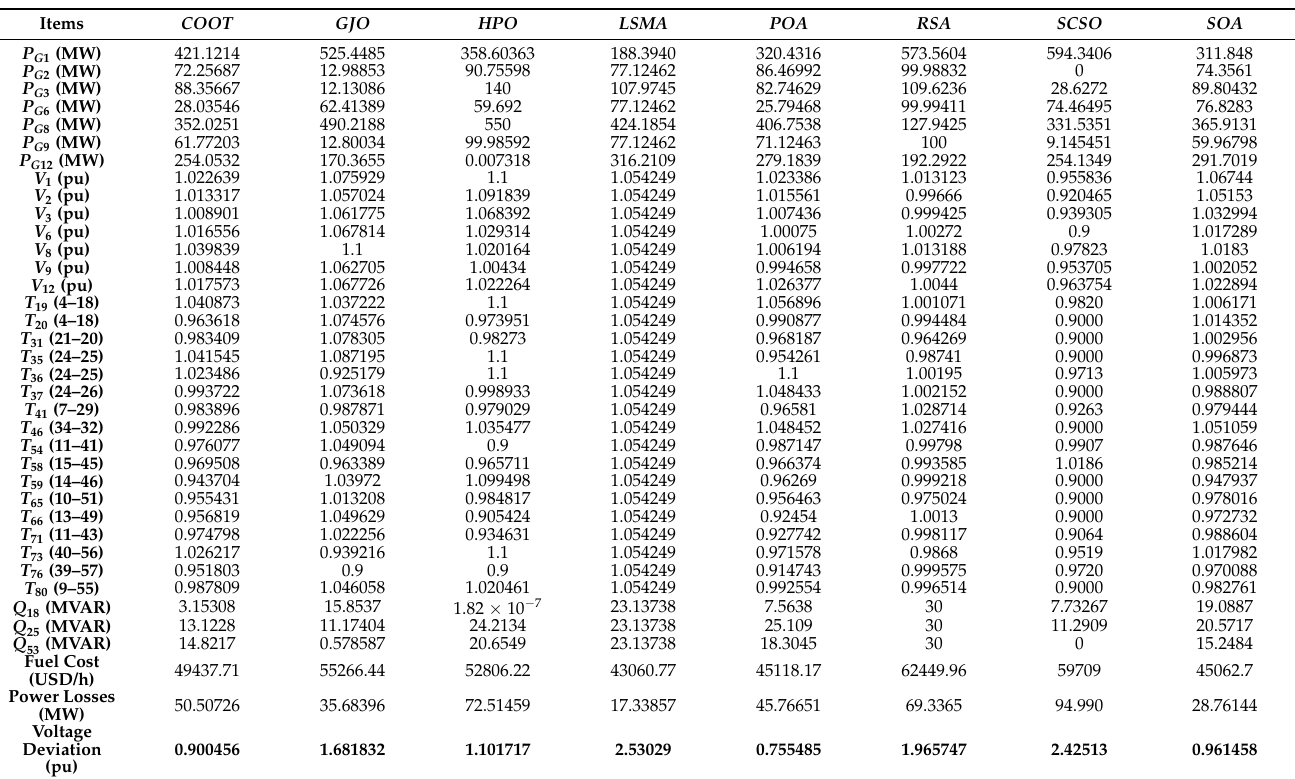
Table 9. Optimal control variables for the IEEE-57 bus test system for minimizing voltage